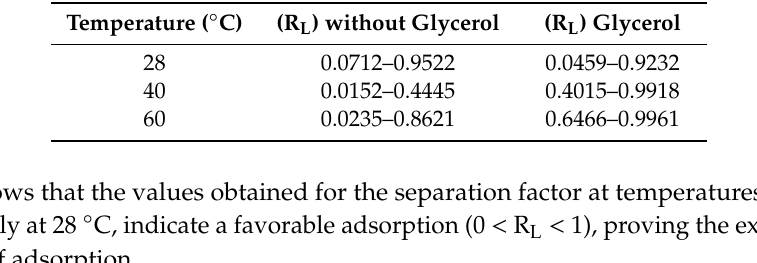
Table 3. Data R L (separation factor) for adsorption with and without